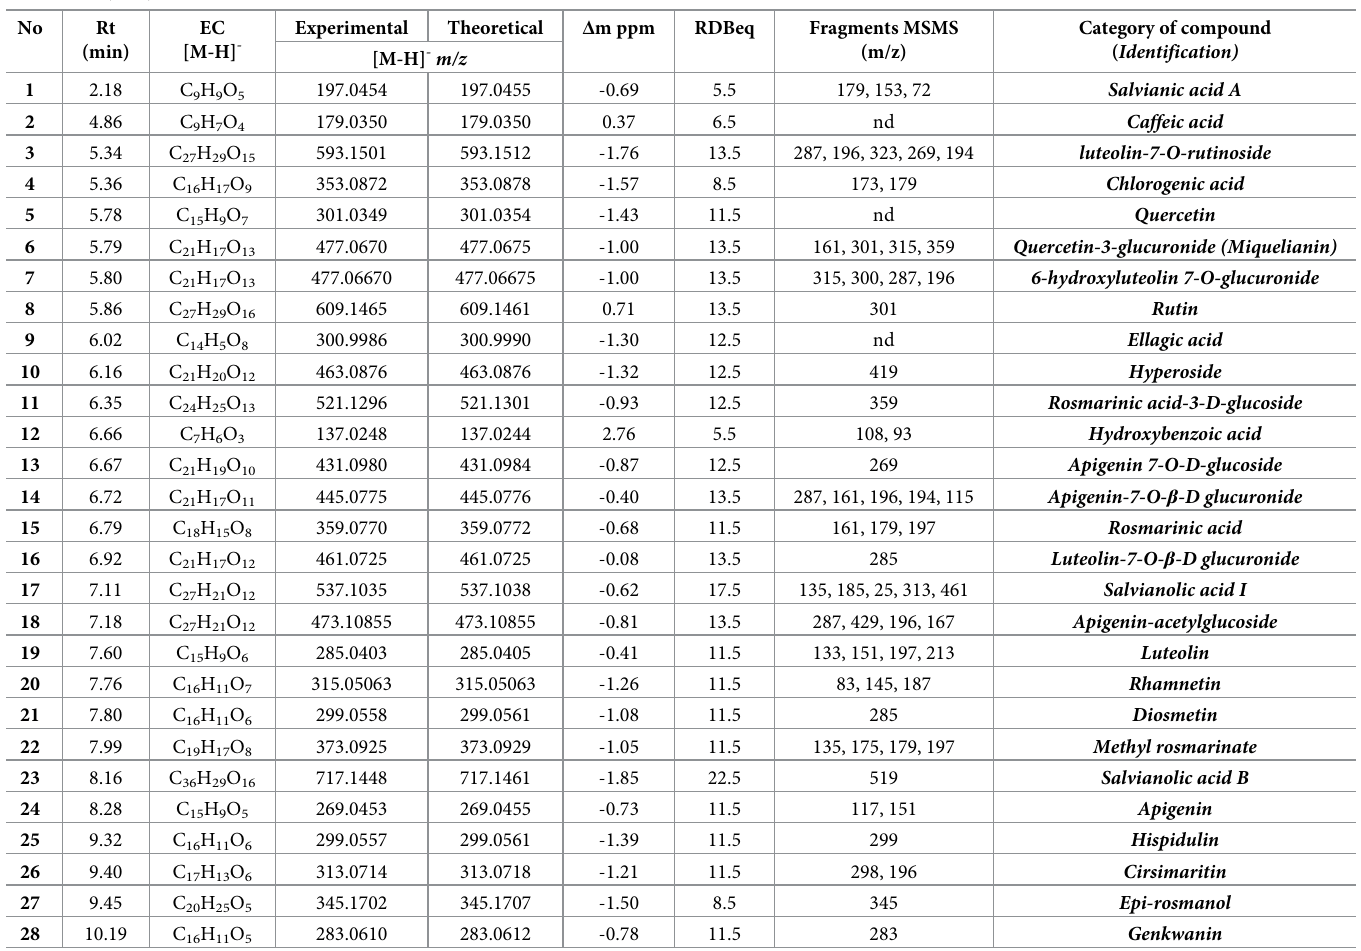
Table 2. LC(ESI-)HRMS of S . sclarea methanol